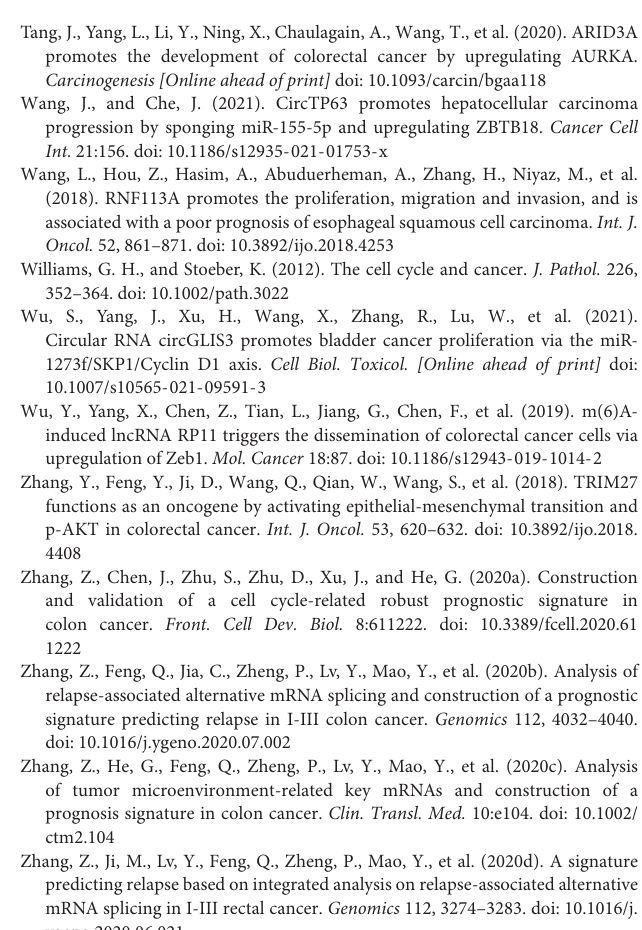
Supplementary Table 2 | Detailed information of three differential analyses of the 24 E3. Supplementary Table 3 | Detailed interactions in the PPI network. Supplementary Table 4 | Detailed information of genes involved in the